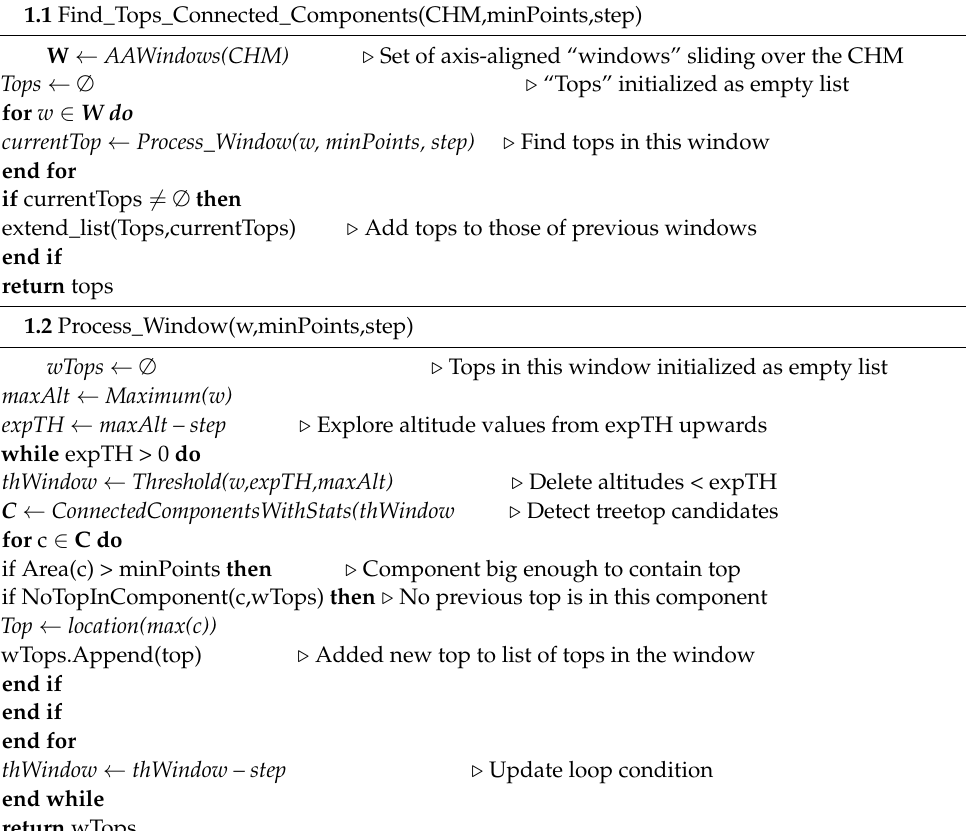
Algorithm 1. Treetop determination and sliding window description as